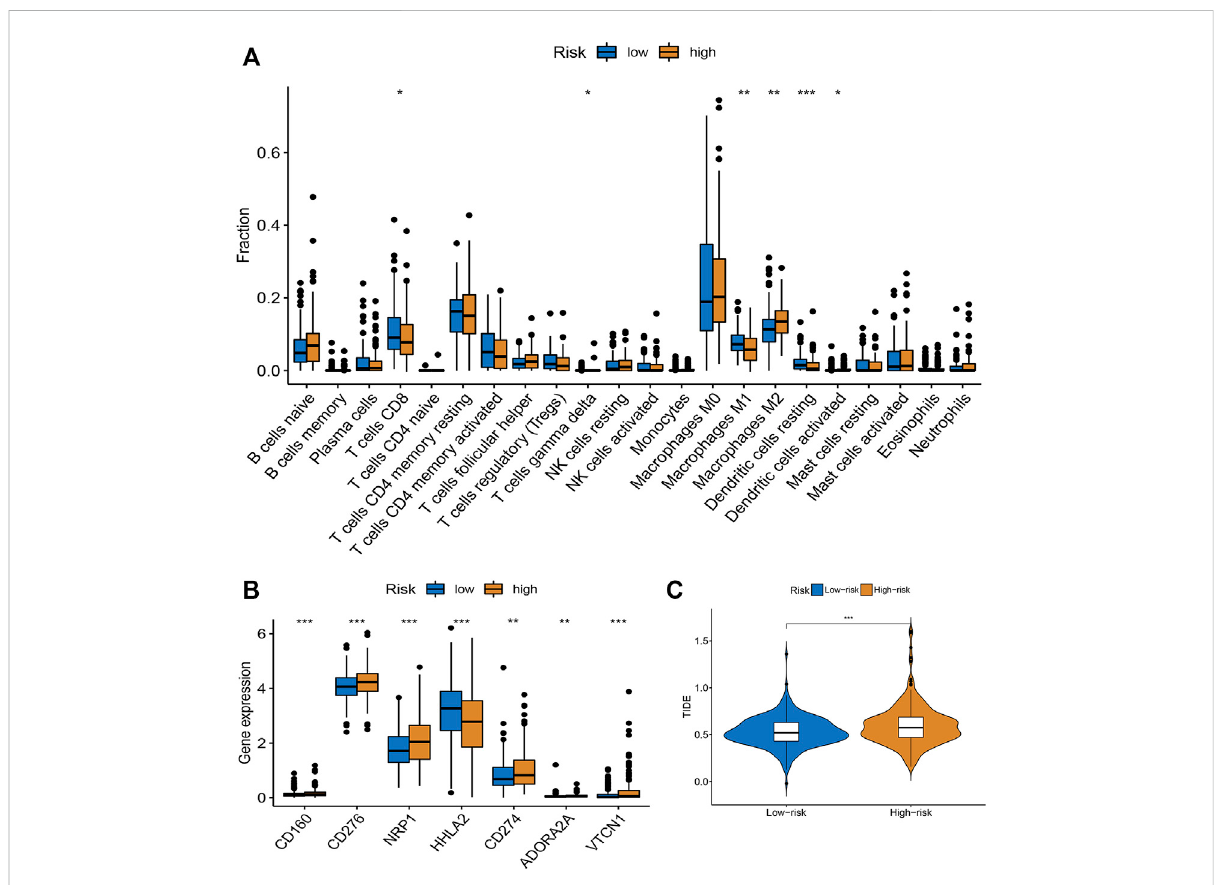
FIGURE 4 Evaluation of TME and immunotherapy response in different subgroups. (A) Comparison of 22 immune cells between low- and high-risk groups. Median values and IQR for each cell subset were calculated for each patient group and compared between the two groups using